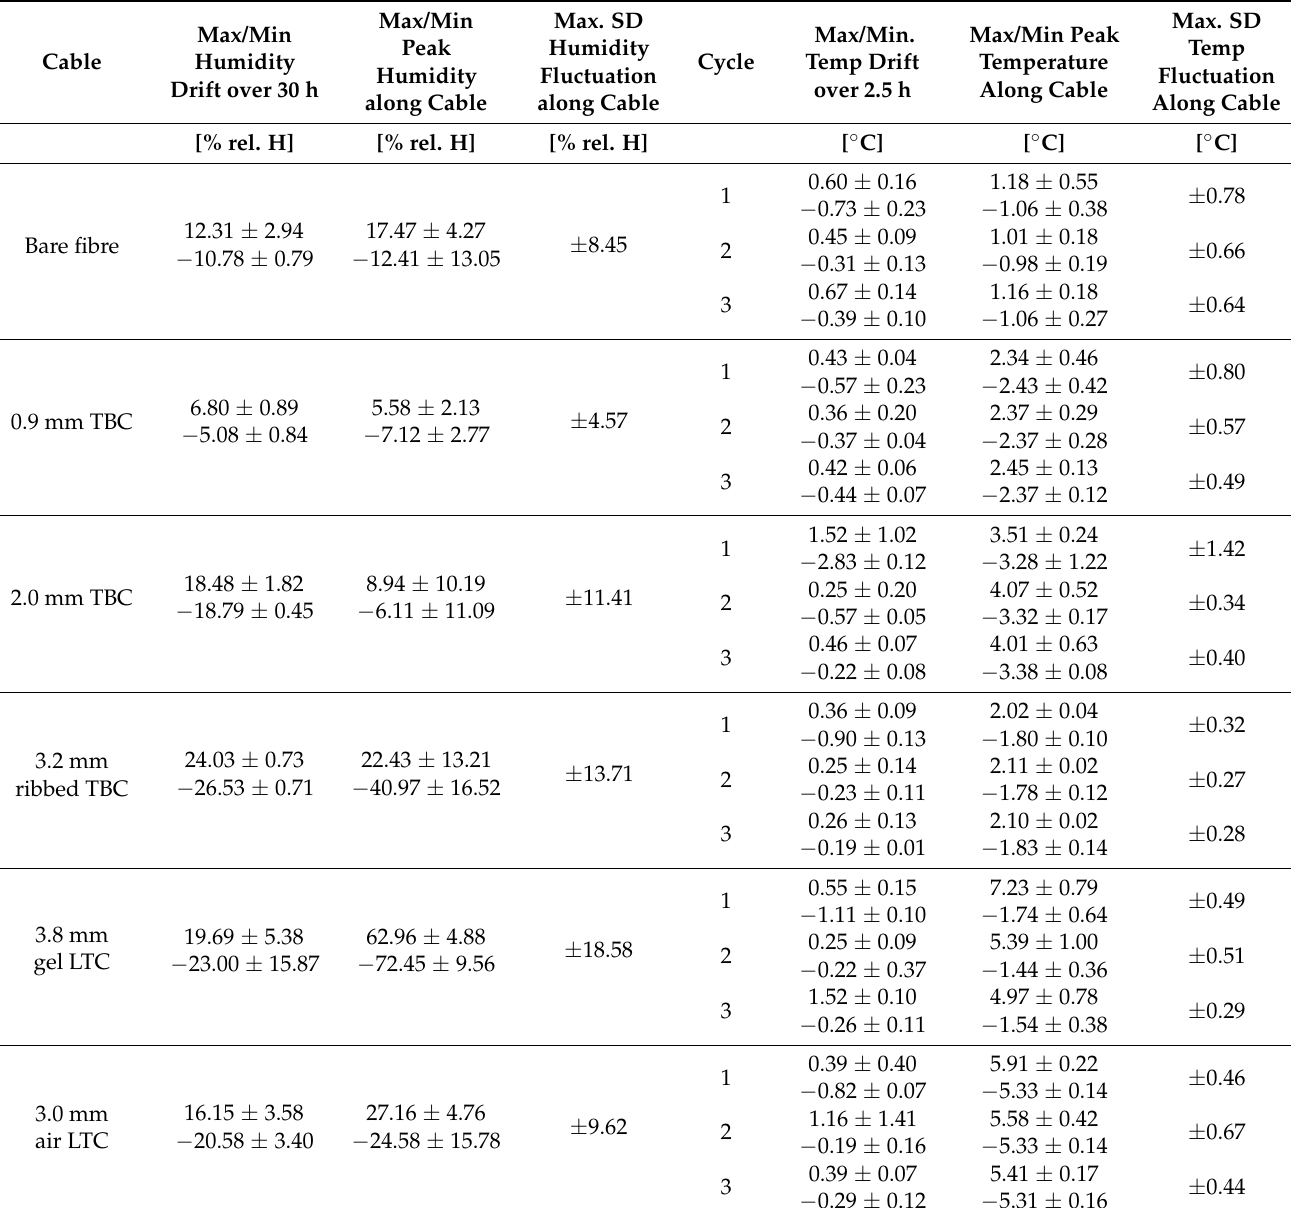
Table 7. Analysis of humidity and temperature including the max/min drift, max/min peaks along the length and max standard deviation, SD (shown in shaded